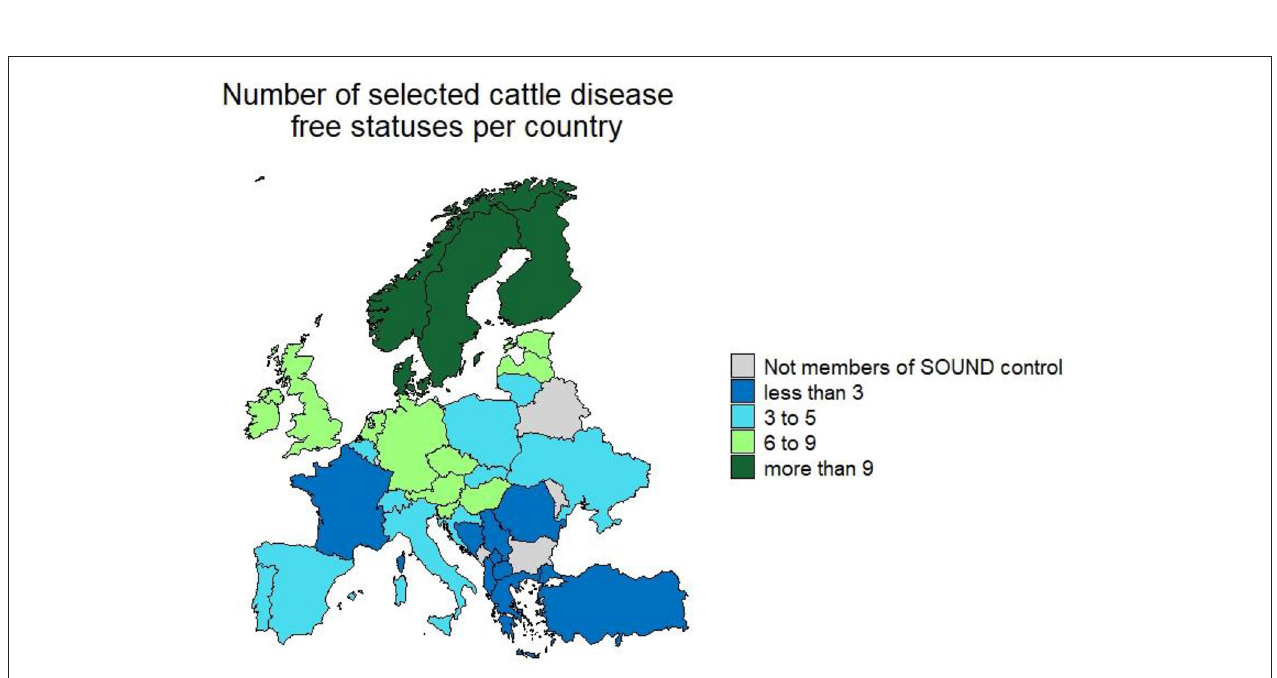
FIGURES 3 | Number of selected cattle disease-free statuses in countries participating in Standardising output-based surveillance to control non-regulated diseases of cattle in the European Union (SOUND control).